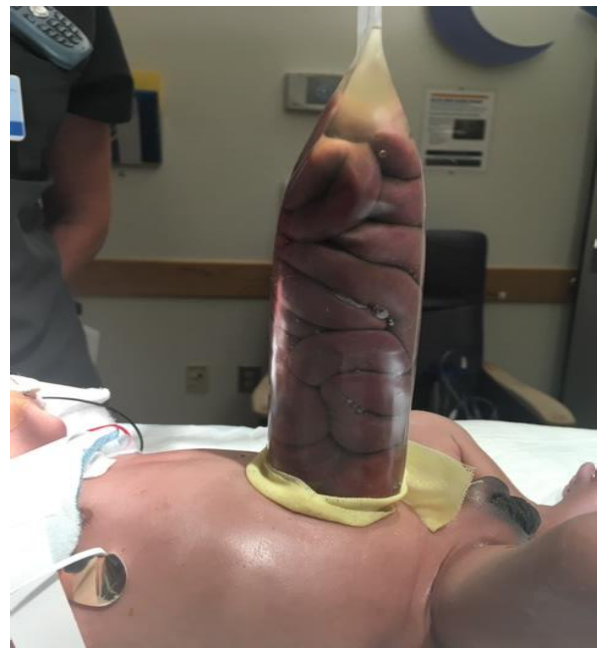
Figure 2. Staged reduction of gastroschisis. Shown is a picture with the bowel loops placed in a silo.